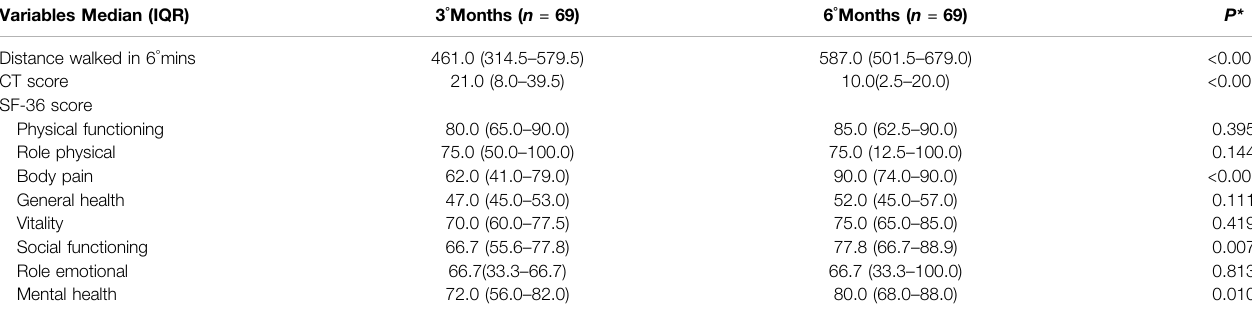
TABLE 1 | Ability to exercise and health-related quality of life among patients during the fi rst 6 ° months after discharge. Variables Median